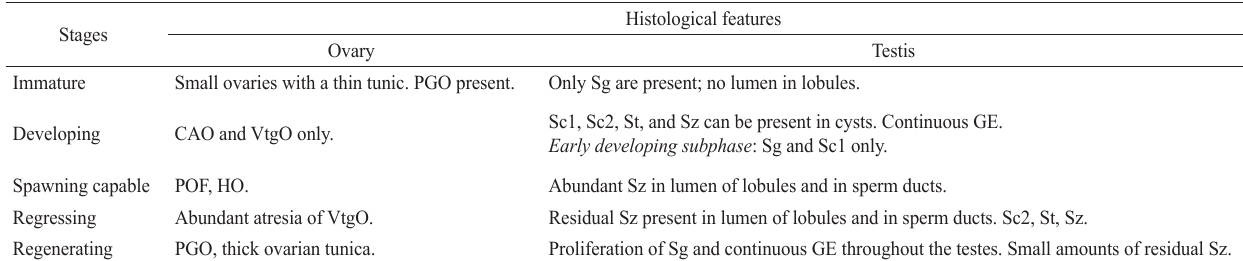
Table 2. Gonad maturity classification in Pinguipes brasilianus based on a modified microscopic classification scheme proposed by Brown-Peterson et al . (2011). CAO: Cortical alveoli oocyte; GE: germinal epithelium; HO: hydrated oocyte; PGO: primary growth oocyte; POF: postovulatory follicle; Sc1: primary spermatocyte; Sc2: secondary spermatocyte; Sg: spermatogonia; St: spermatid; Sz: spermatozoa; VtgO: vitellogenic